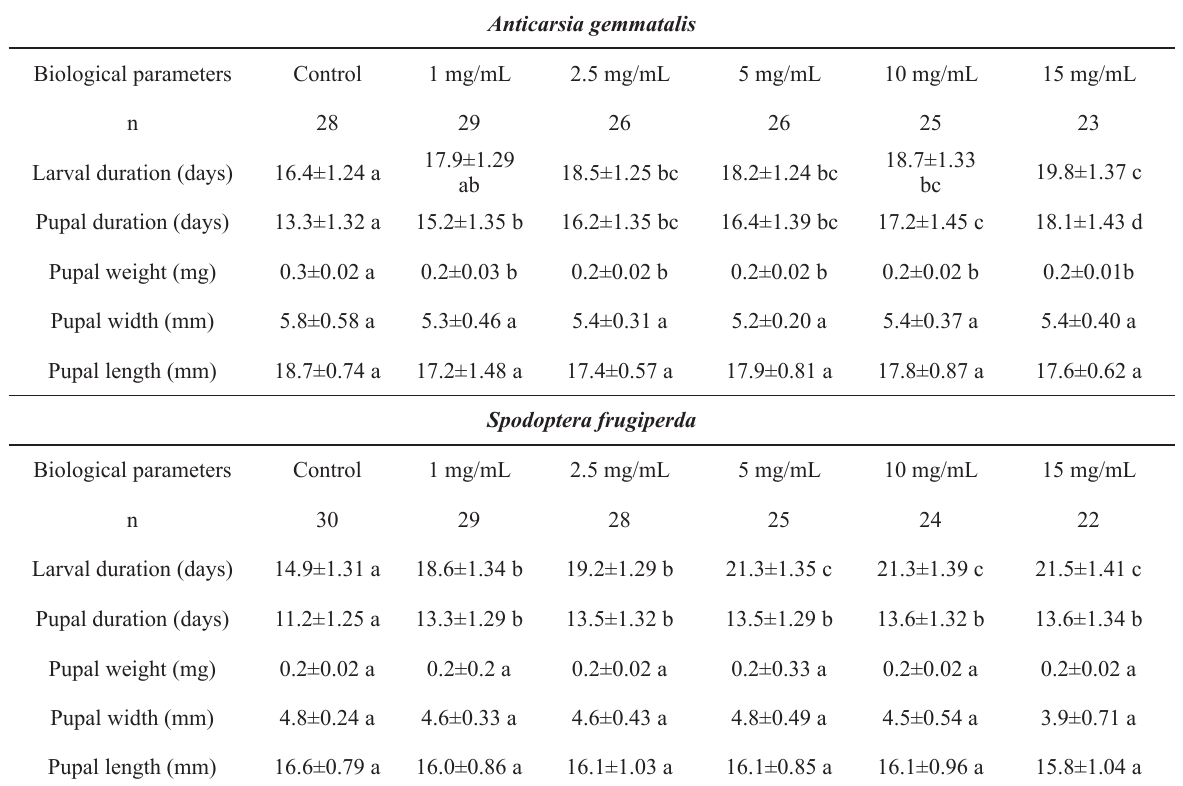
Biological parameters of Anticarsia gemmatalis and Spodoptera frugiperda fed artificial diet containing the ethanol extract of Piper aduncum leaves